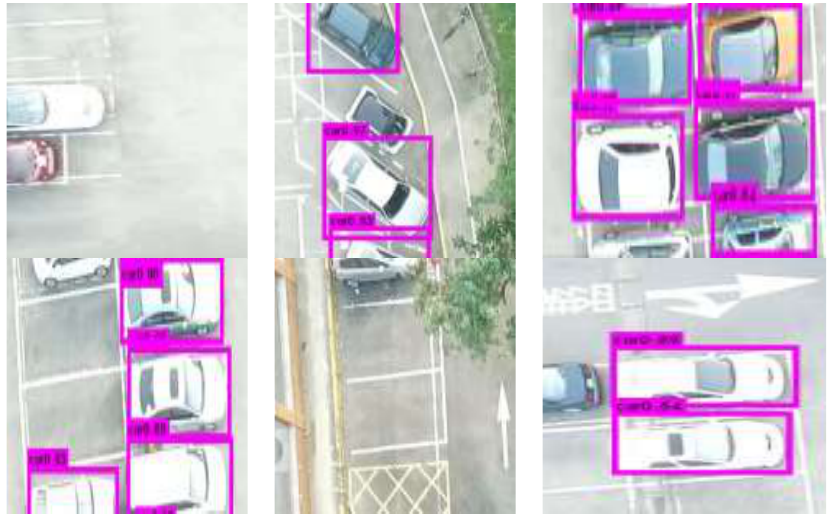
Figure 3. YOLOv3 missed detection examples for partially occluded targets: Vehicles not marked by purple boxes are missed targets.